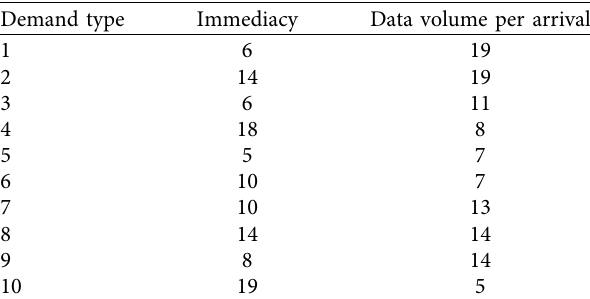
Figure 3: Illustration of the physical meaning of net spectral efficiency. Table 1: Differences between the three business types.